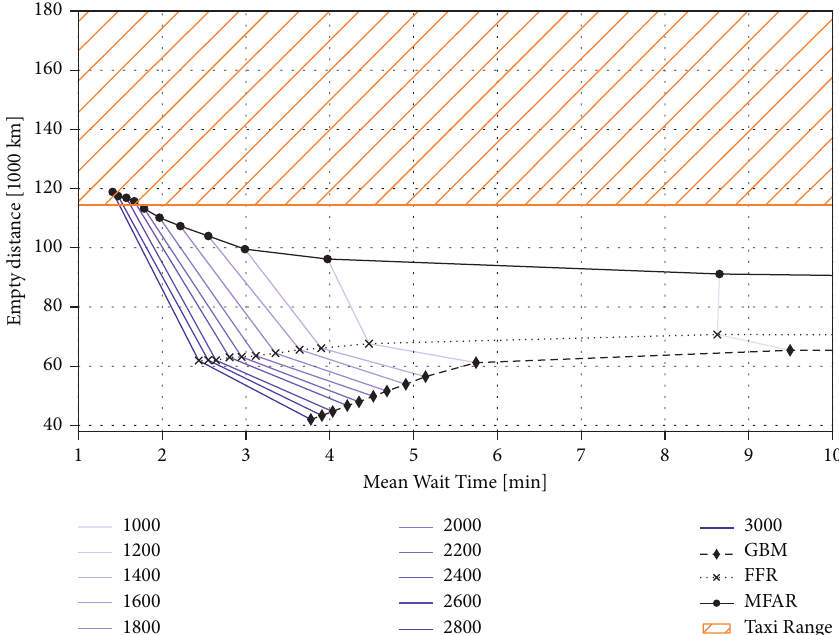
Figure 5: Mean wait time and empty distance of a coordinated mobility-on-demand system under different operational policies and fleet sizes for the Chicago case. The real taxi system in orange uses 2,479 taxis. Wait times lower than in the coordinated system are unlikely but cannot be fully excluded based on the data.